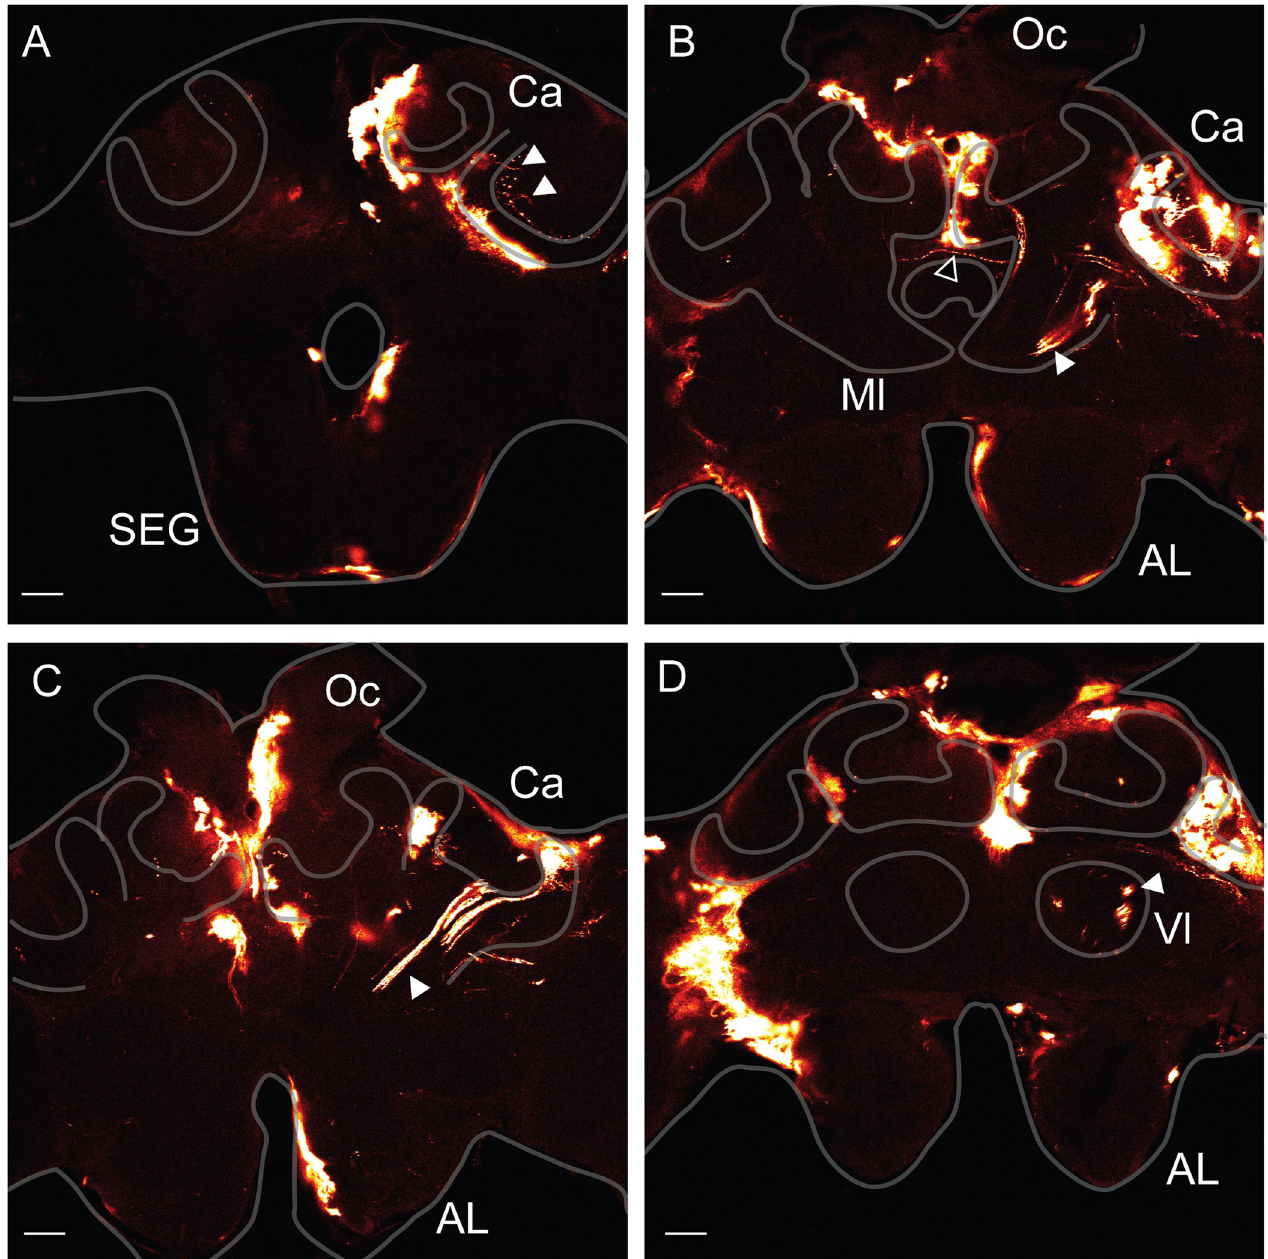
Fig 4. Anti-eGFP signal detected in Kenyon cells. The animals were injected through the median ocellus and electroporated with the plate electrodes at 100 V, 5X 50 ms pulses. A. Section of the brain at the level of the suboesophageal ganglion ( SEG ). The white arrow head shows KC somata connected to neurites projecting into the calyx ( Ca ) and to their dendrites. B. Section of the brain at the level of the central complex. The white arrow head shows the axons of KC terminating into the median lobe ( Ml ). eGFP positive signals were also detected into the calyx ( Ca ). The black arrowhead shows the axon of a neuron crossing laterally the brain. C. Section of the brain at the level of the antennal lobe ( AL ). The white arrow head shows KC axons projecting into the neck and the peduncle of the MB. D. Section of the brain at the level of the antennal lobe ( AL ) and the vertical lobe ( Vl ). The white arrow head shows KC terminals in the Vl. Scale bar: 100 μ